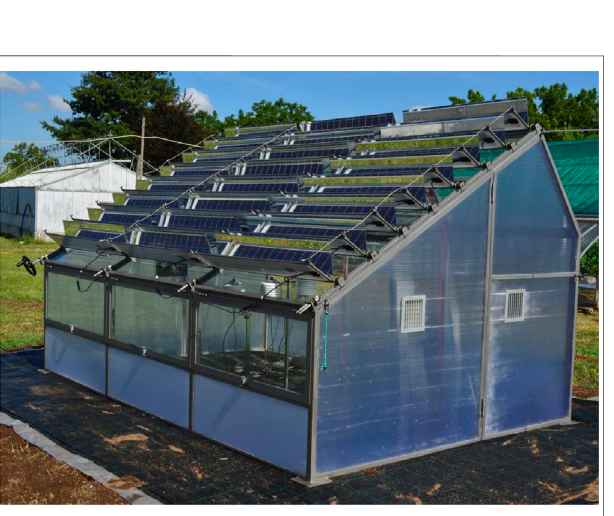
Frontiers in Energy Research |